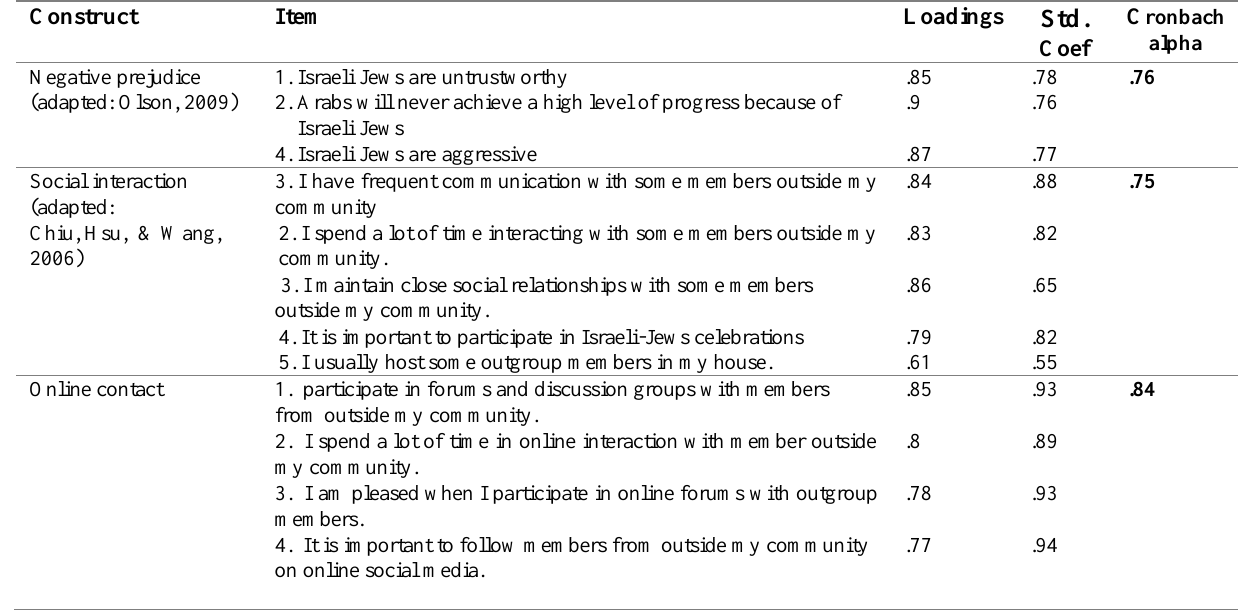
Table 1: Item loadings constructs’ reliability and validity